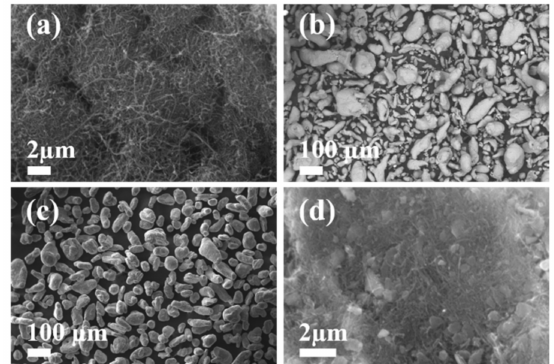
Figure 1. SE-SEM micrographs for: ( a ) highly entangled and agglomerated as-received MWCNTs; ( b ) as-received Al powder; ( c ) uniform size distribution of ball-milled Al-MWCNTs nanocomposite powders; ( d ) MWCNTs dispersion within the ball-milled Al powder